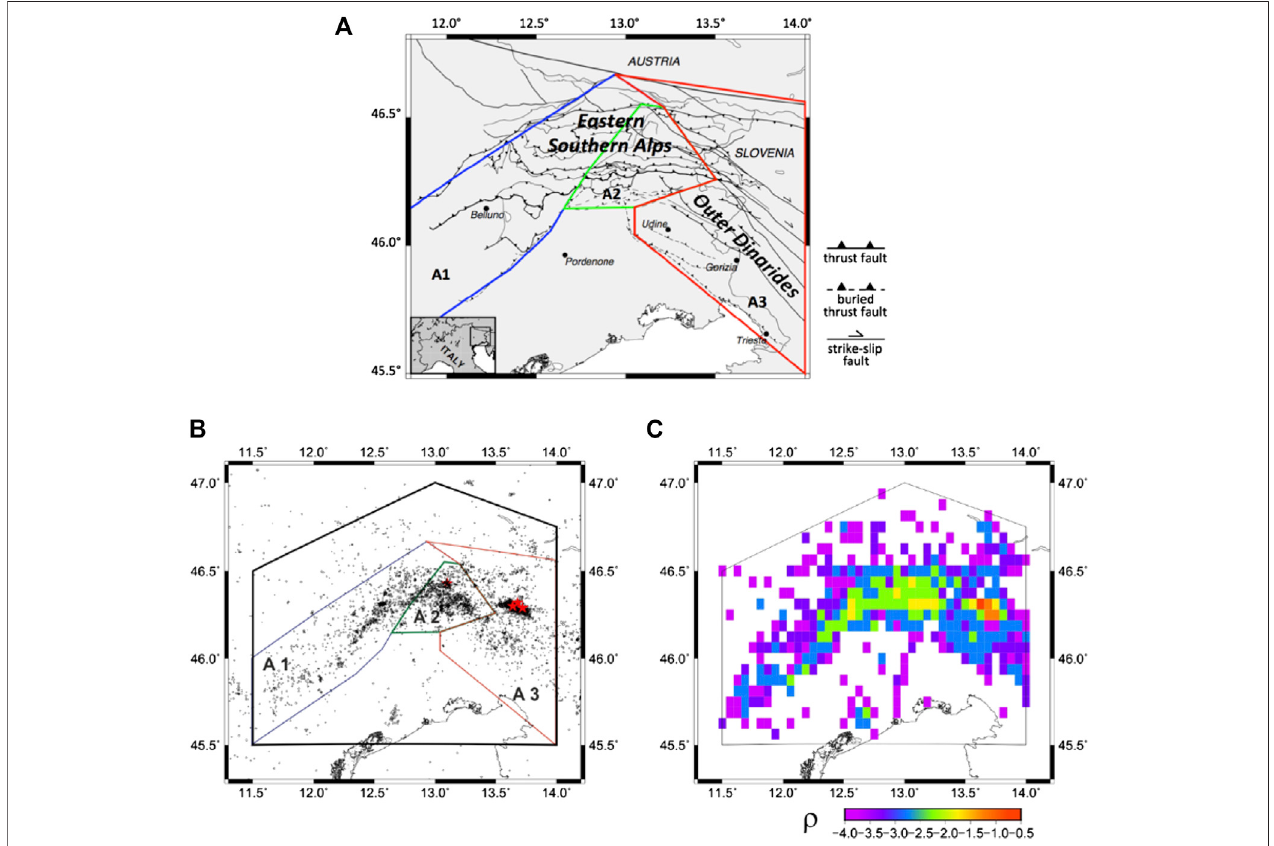
FIGURE 1 | The spatial data distribution based on OGS catalog, 1/1/1995 – 21/03/2019 (A) Map of tectonic lineaments after Bressan et al. (2018) and A1, A2 and A3sub-regionsborders(blue,greenandredpolygons); (B) M